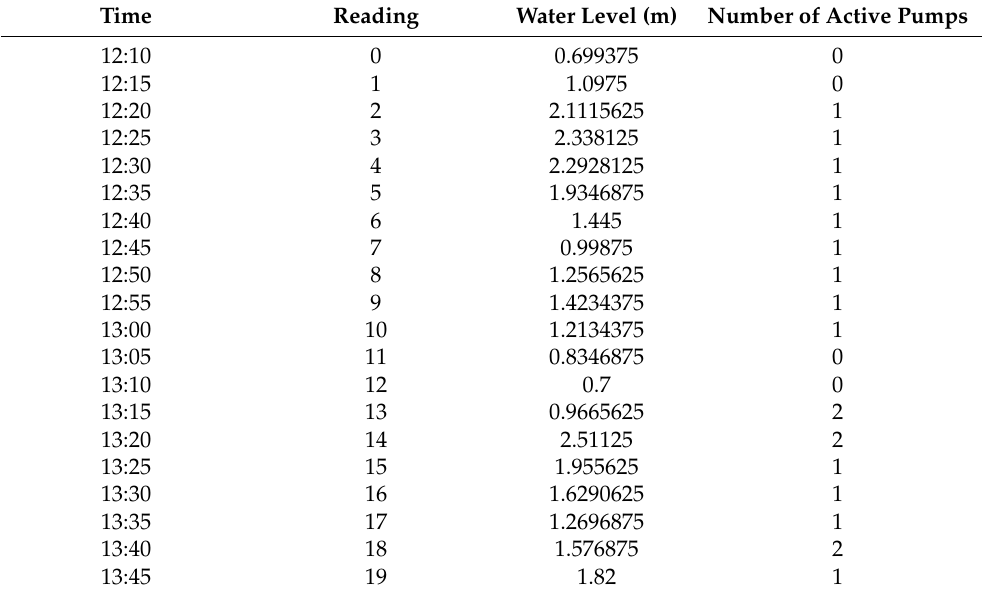
Table 2. Sequence of 20 rows of the original data